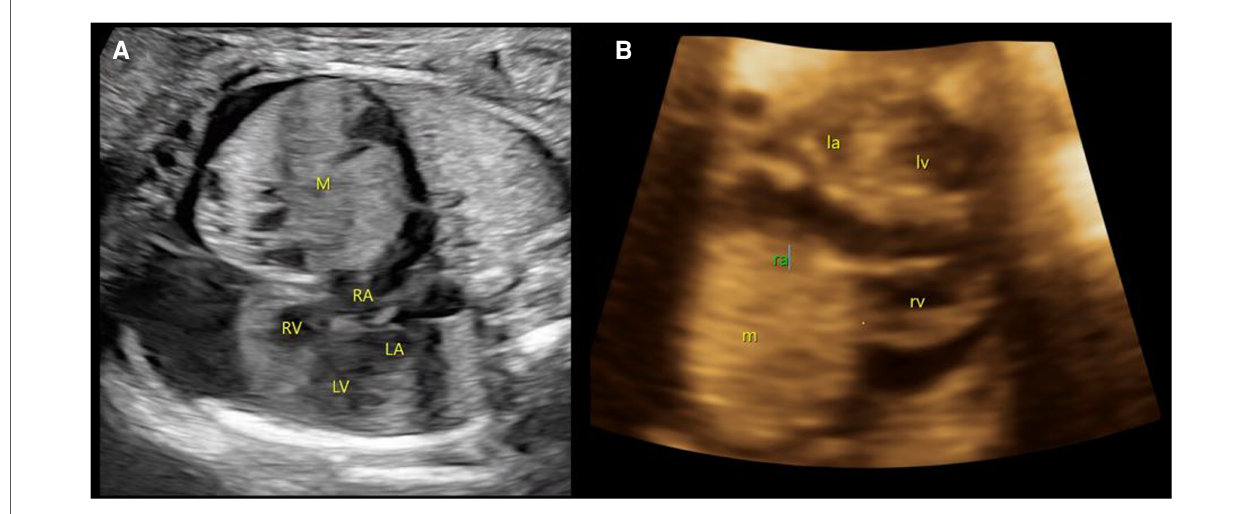
FIGURE 1 Prenatal ultrasound images. ( A ) At 26 weeks of gestation, a mixed mass (M) in the pericardium of the fetus with size approximately 27×26 mm with pericardial effusion is demonstrated. ( B ) At 37 weeks of gestation, a slightly strong echo mass (m) can be seen in the right pericardial cavity, with a range of approximately 37×36 mm. M/m, mass; RA/ra, right atrium; RV/rv, right ventricle; LA/La, left atrium; LV/Lv, left ventricle.